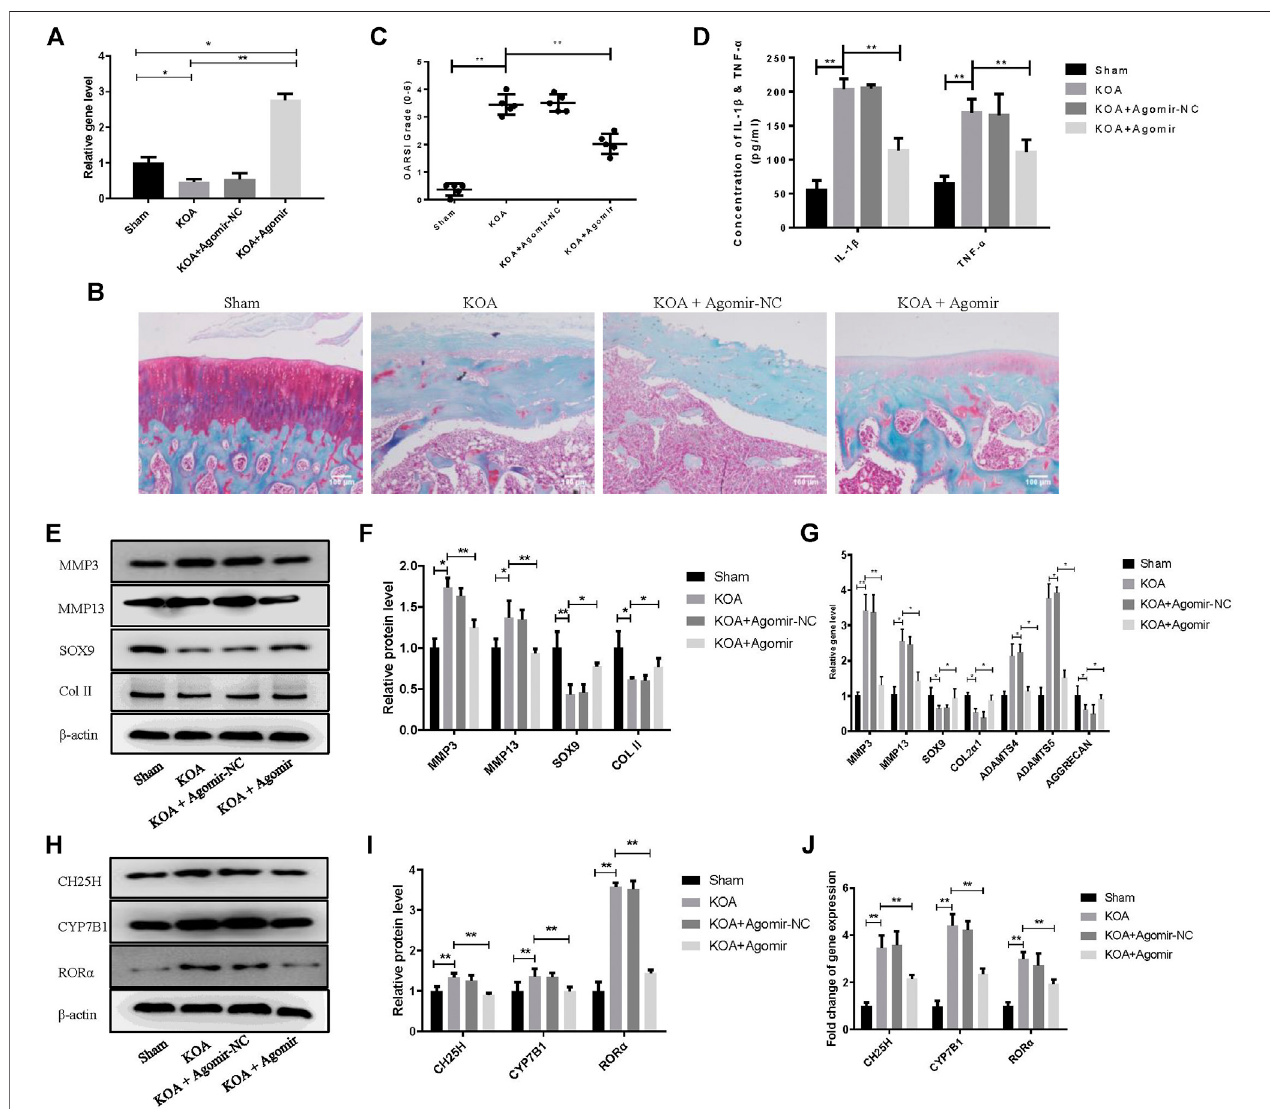
FIGURE6| MiR-10a-3pimprovescartilagedegenerationinKOAmodelrats. (A) Detectionoftransfectionef fi ciencyofmiR-10-3p agomirbyqRT-PCR. (B) Saffron Red & Fast green staining of cartilage tissue, 100 × , Scale bar (cid:1) 100 μ m. (C) OARSI scores of cartilage tissue in different groups ( n (cid:1) 5). (D) Concentration of IL-1 β and TNF- α in serum were detected by ELISA. (E , F) MMP3, MMP13, SOX9, and Collagen II expression in cartilage tissue were analyzed via western blotting. The band intensity was quanti fi ed by normalizing to β -actin ( n (cid:1) 3). (G) MMP3, MMP13, SOX9, COL2 α 1, ADAMTS4, ADAMTS5, and Aggrecan expression in cartilage tissue were analyzed via qRT-PCR. Quantitative data were presented as mean ± SD. (H , I) CH25H, CYP7B1, and ROR α expression in cartilage tissue were analyzed via western blotting. The band intensity was quanti fi ed by normalizing to β -actin ( n (cid:1) 3). (J) CH25H, CYP7B1, and ROR α expression in cartilage tissue were analyzed via qRT-PCR. Quantitative data were presented as mean ± SD. * p < 0.05, ** p < 0.01.